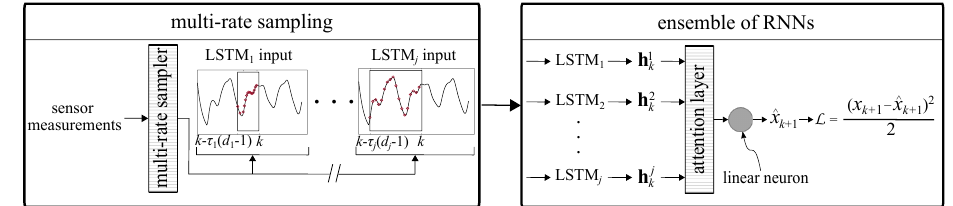
Figure 1. Deep learning architecture: ensemble of RNNs for one-step ahead